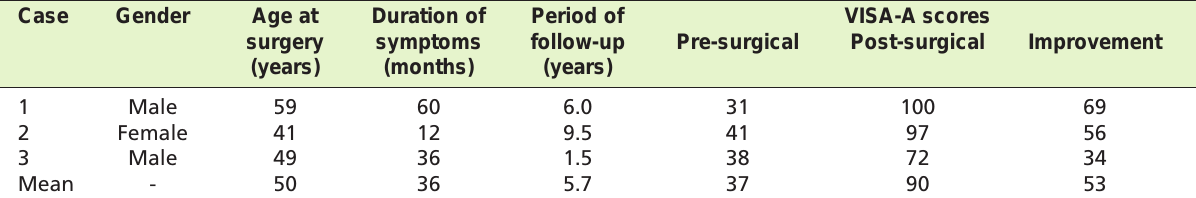
Patient demographics and VISA-A scores from pre- to post-surgical follow-ups in all three Table I: